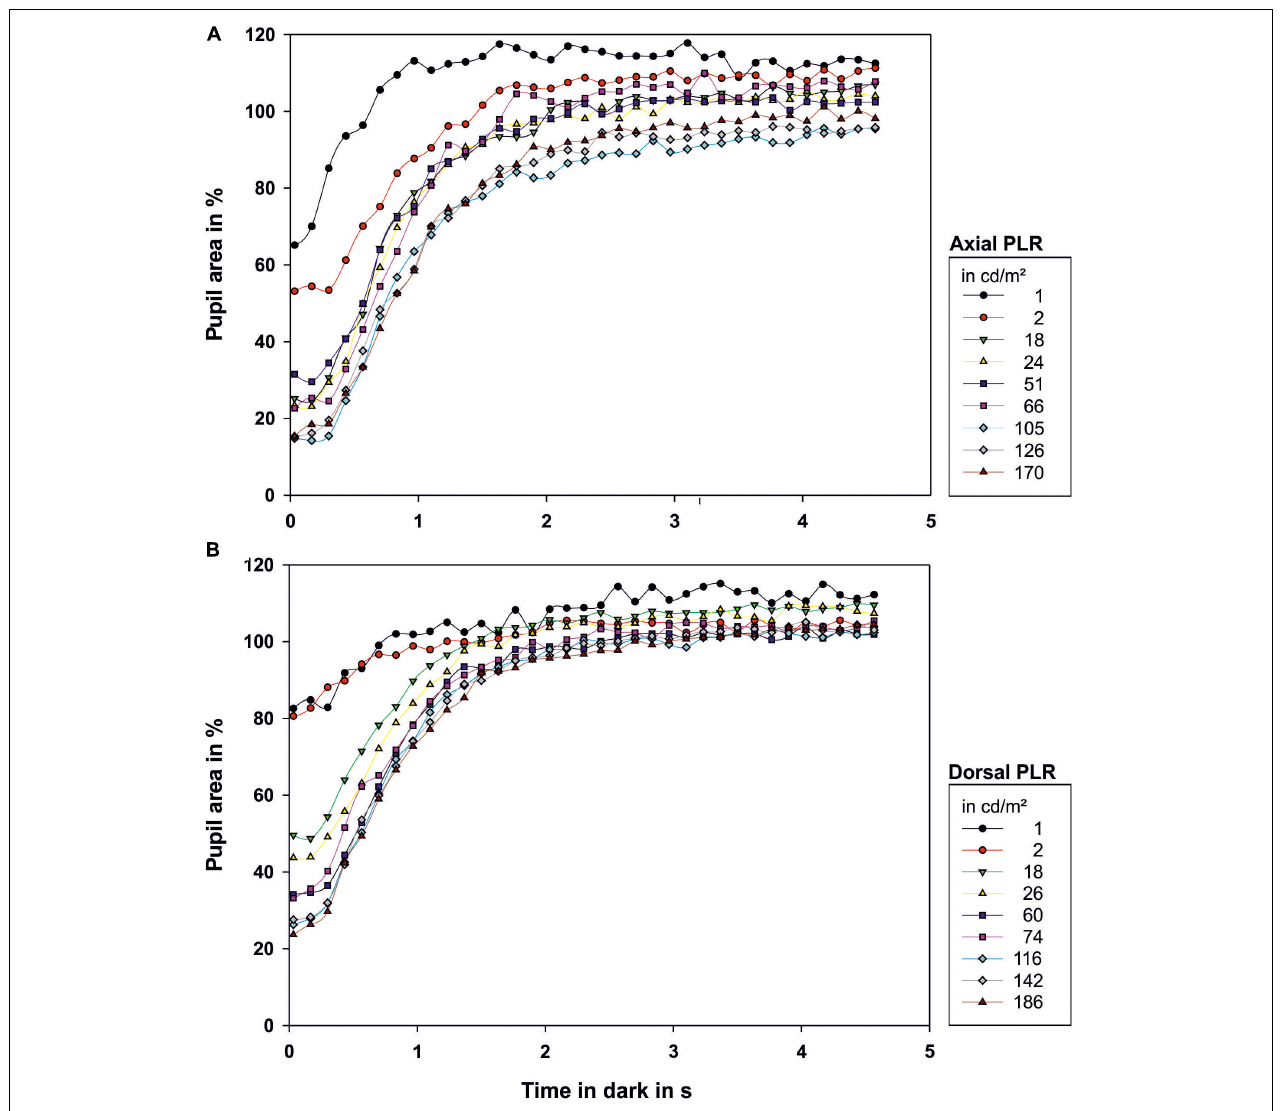
FIGURE 5 | Dark reaction of the octopus pupil when (A) illuminated axially or (B) from dorsal. The pupil size on the first frame of the light period was taken as 100% pupillary area. Therefore values above 100% occur. Zero on the time axis indicates when the light was switched off. Each data point represents the mean value of the pupillary area of 3–9 measurements. The luminance of the light source in cd/m 2 in the light period preceding the respective dark phase 2 is indicated in the